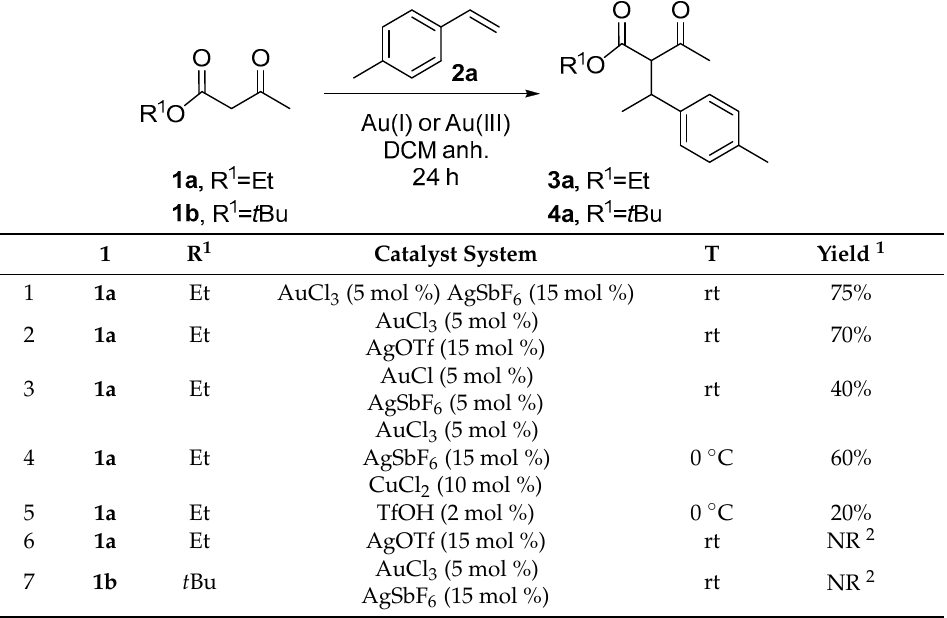
Table 1. Gold-catalyzed hydroalkylation of p -methylstyrene ( 2a ) with β -ketoesters 1a and 1b .